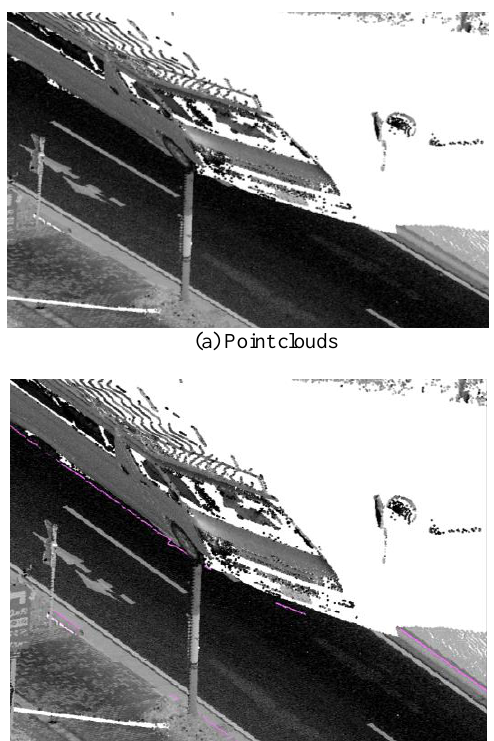
Figure 10. Mistakenly extracted due to running parallel